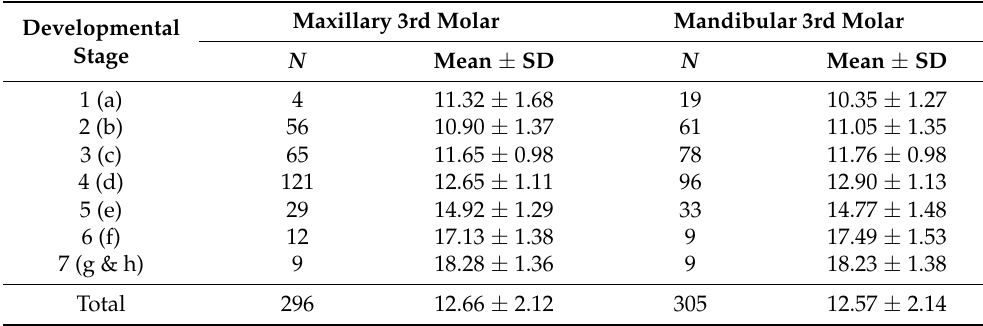
Table 1. Maxillary and mandibular Demirjian developmental stages—number of cases ( N ) and mean age distribution (+ standard deviation). Stages 7 and 8 were merged into a single group due too few